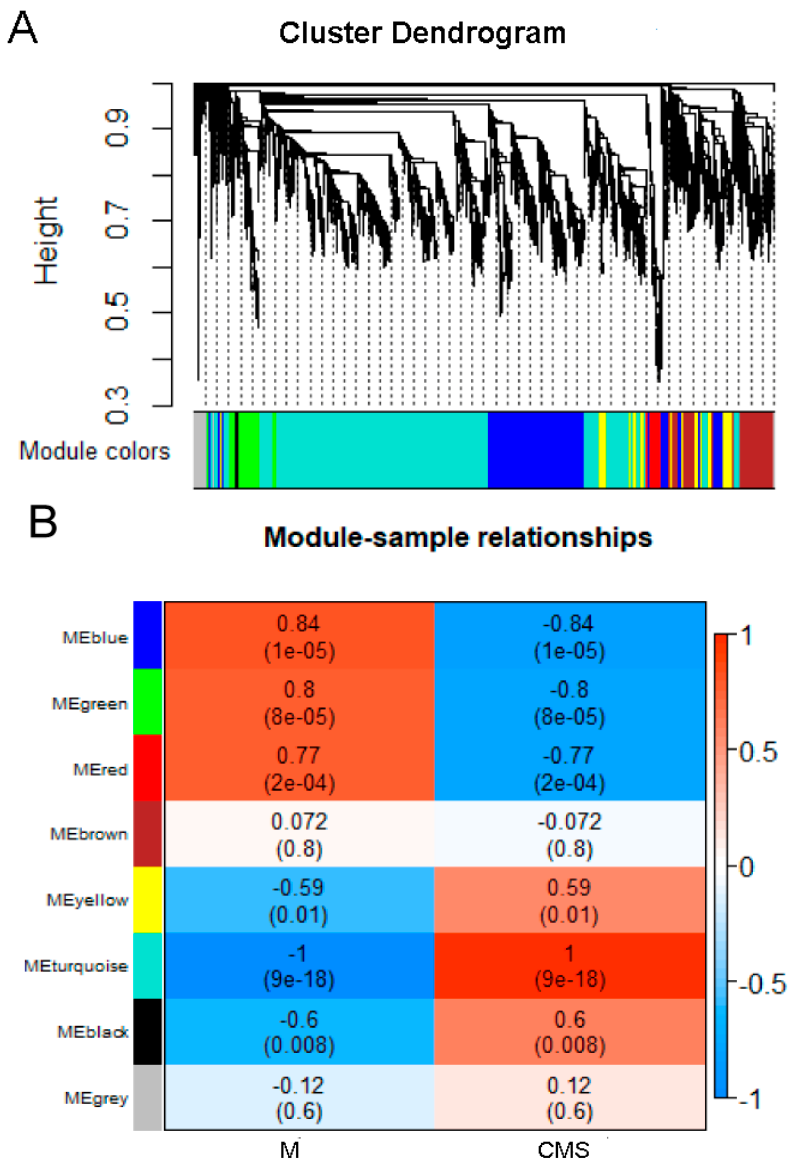
Figure 7. WGCNA analysis of CMS related genes. ( A ) Hierarchical clustering tree showing co-expression modules. In the tree, each leaf represents one gene. The major tree branches constitute seven modules, labeled by different colors. ( B ) Module-trait relationship. High correlation between a specific module and the sample is shown in dark red or dark blue. M, maintainer line C2P5B; CMS, cytoplasmic male sterile line C2P5A.